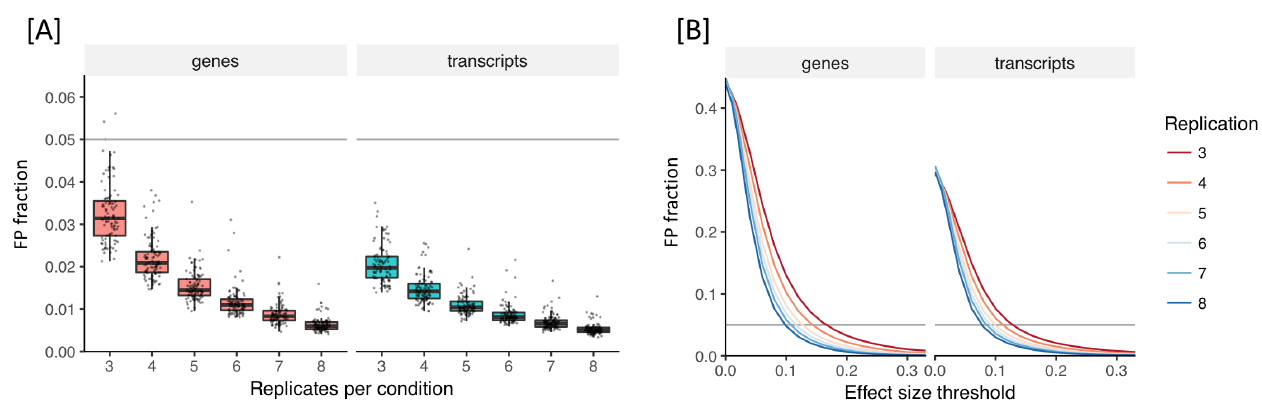
Figure 2. False positives (FP) performance of RATs as a function of replication level. False positive fraction measured over 100 permutation iterations of randomly selected (without replacement) replicates from a pool of 16 high-quality wild-type Colombia-0 Arabidopsis thaliana replicates from Froussios et al. (2017, 29 ). [ A ] FP fraction of each bootstrap iteration, for default values of all RATs parameters (v0.6.2), across a range of replication levels, separately for the gene-level test (red) and transcript level test (blue). [ B ] Mean FP fraction by replication level, as a function of the effect size threshold (effect size = difference between conditions of an isoform’s proportion). For a gene, the effect size is defined as the largest proportion difference observed among that gene’s isoforms. In every iteration, the FP fraction was calculated against the number of genes or transcripts that were eligible for testing each time (a number which remains very stable across iterations and replication levels – see Extended data 1 33 ).